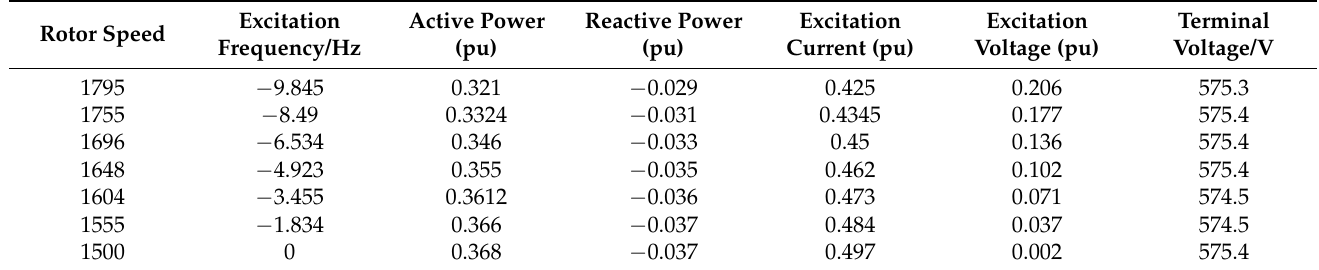
Table 5. The change in rotor speed at a given power at a wind speed of 10 m/s.